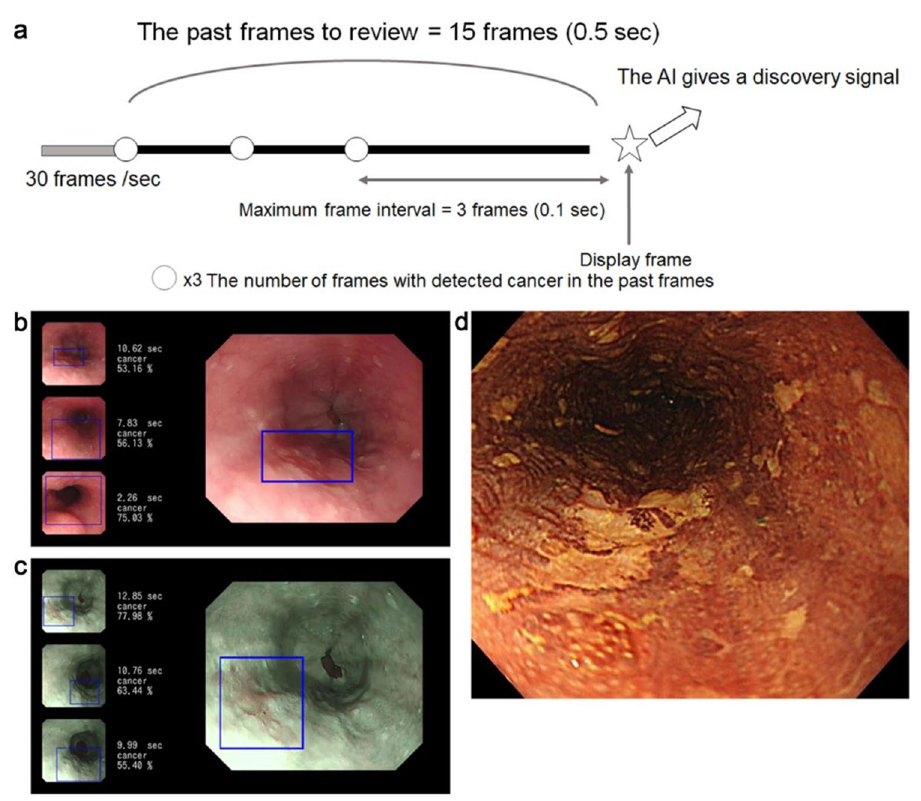
Figure 1. System of AI diagnosis in endoscopic videos and representative images of AI detection of ESCC. ( a ) When the AI detected a cancerous lesion, the AI reviewed the video for 0.5 s (15 frames). If the reviewed section of video included a cancer image in more than 3 frames and the maximum interval from the latest cancer image was 0.1 s (3 frames), the AI diagnosed the lesion as cancer, giving a discovery signal. ( b , c ) When the AI recognized a cancerous lesion, a frame was displayed in the endoscopic image surrounding the lesion of interest. The AI inserted the image of the recognized cancer on the left side of the monitor, indicating that it diagnosed the lesion as cancerous. ( d ) When the AI-diagnosed cancer matched the iodine unstained area which was pathologically diagnosed as an ESCC, the AI was considered correct. AI: artificial intelligence, ESCC: esophageal squamous cell